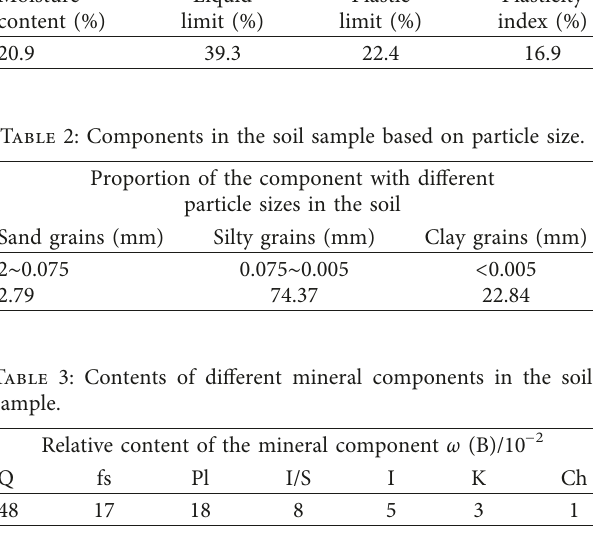
Note . Q denotes quartz, fs denotes alkali feldspar, PI denotes plagioclase, I/S denotes illite/smectite formation, K denotes kaolinite, I denotes illite, and Ch denotes chlorite.